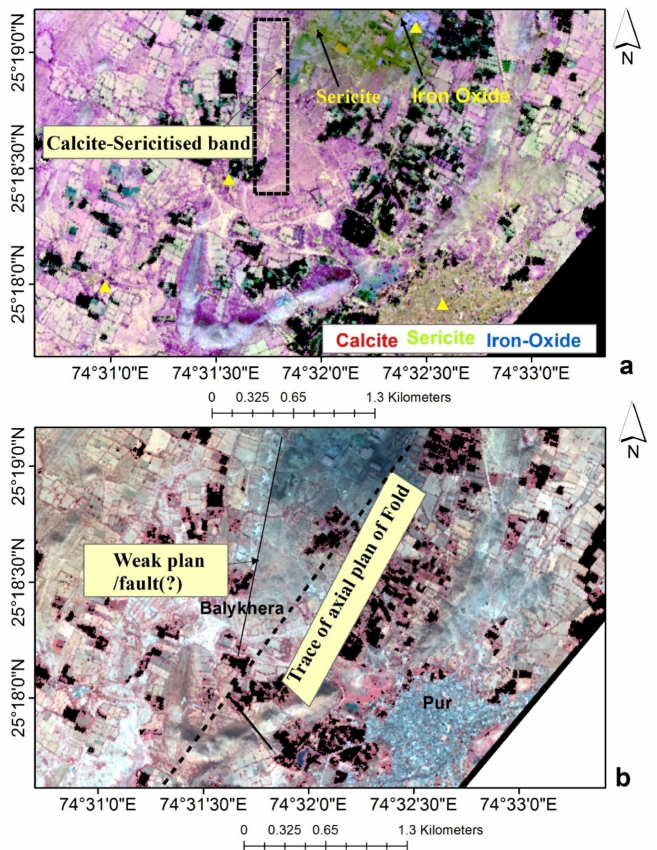
Figure 17. ( a ) False color composite map of calcite, sericite, and iron oxide RBDs to detect calcite- sercite veins within BMQ around Balykhera area ( b ) FCC image composite of AVIRIS-NG bands show- ing important structural controls that might have facilitated ore-bearing fluid migration, alteration zone development, and mineral enrichment. In the AVIRIS image, Red = 850 nm, Green = 650 nm, and Blue = 560 nm.